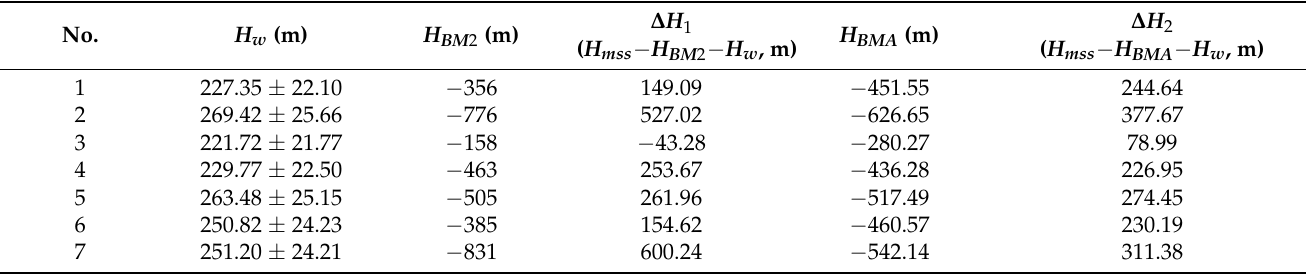
Figure 5. Locations and the circumcircle of grounding points and the difference between seabed elevations from BedMachine and BedMap2 data. Table 3. Maximum water depths ( H w ) at grounding points and the corresponding seabed eleva- tions from BedMap2 H BM2 and BedMachine ( H BMA ), together with the differences in water depths estimated ∆ H 1 , ∆ H 2